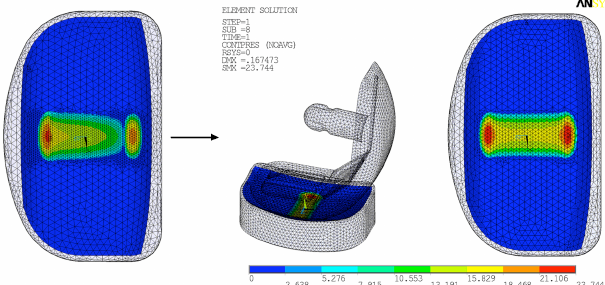
Fig.11 Result of optimization on a type with free PE insert in position 5